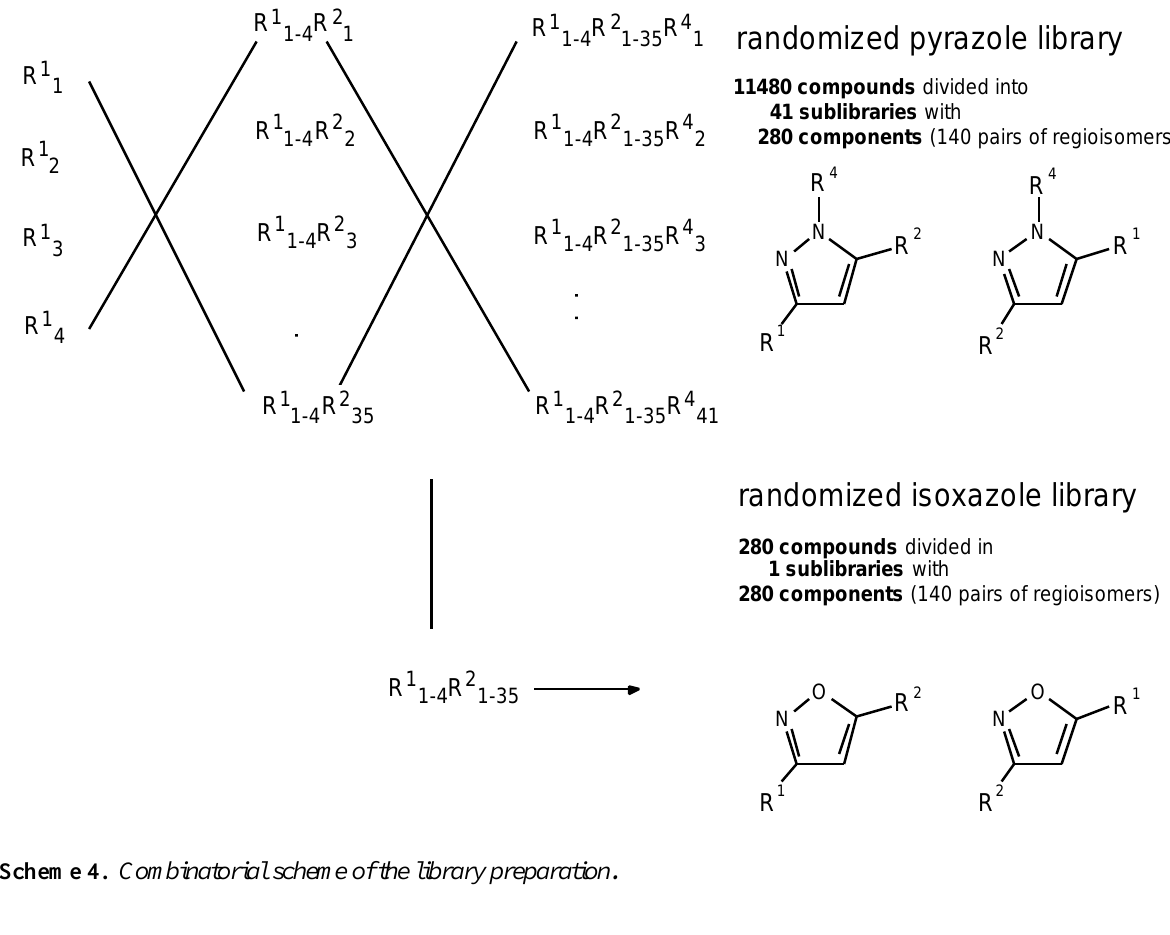
Scheme 4. Combinatorial scheme of the library